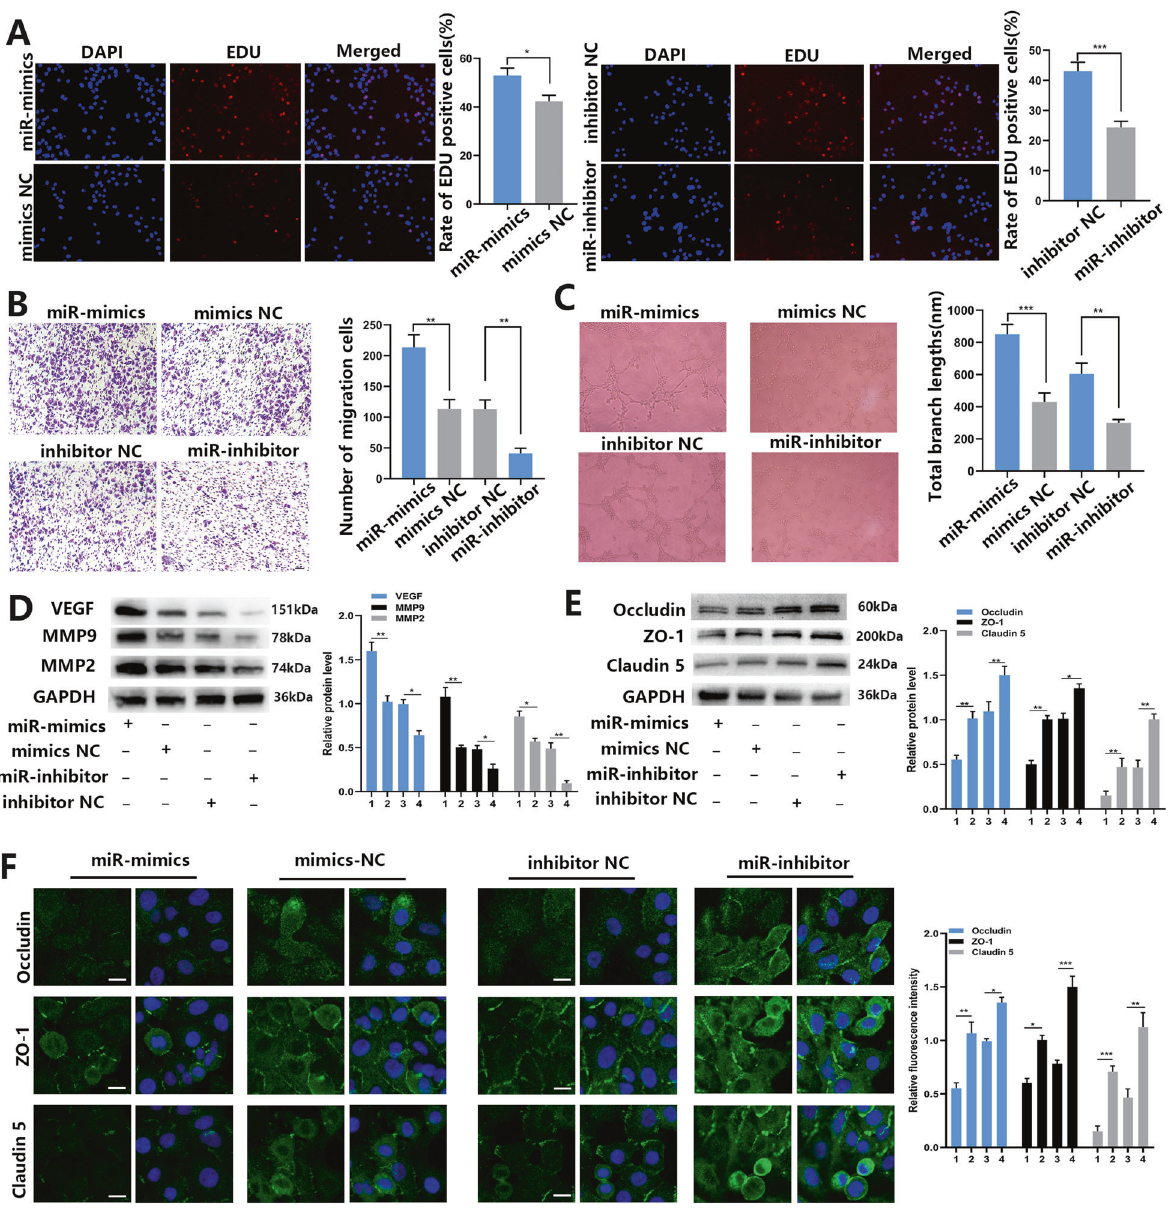
Fig. 3 Restored miR-3157-3p enhances HUVEC proliferation, migration, tube formation, angiogenesis and permeability. A Proliferation of HUVECs transfected with Lv-miR-3157-3p or Lv-miR-3157-3p-inhibitor detected using EdU assay (×400); B migration of HUVEC transfected with Lv-miR-3157-3p or Lv-miR-3157-3p-inhibitor assessed using transwell assay (×100). C Tube formation of HUVECs transfected with Lv-miR- 3157-3p or Lv-miR-3157-3p-inhibitor (×100). D , E Protein levels of TIMP2, VEGF, MMP2, MMP9,KLF2,ZO-1,Occludin, and Claudin5 of HUVEC transfected with Lv-miR-3157-3p or Lv-miR-3157-3p-inhibitor measured using Western blot analysis; F Immuno fl uorescence staining analysis of ZO-1, occludin, Claudin5 expression in HUVECs ransfected with Lv-miR-3157-3p or Lv-miR-3157-3p-inhibitor. Scale bar, 20 μ m. 1: miR- mimics; 2: mimics NC; 3: inhibitor NC; 4: miR-inhibitor; The data are shown as the mean ± SD (* P < 0.05; ** P < 0.01; *** P < 0.001). angiogenesis and vascular permeability. Related processes include HUVEC proliferation (Fig. 5A), tube formation (Fig. 5B), and migration (Fig. 5C). The expressions of ZO-1, Occludin, and Claudin5 were the proliferation, migration, angiogenesis and increased permeability further studied in the IF experiment (Fig. 5D). To further determine in HUVECs in a manner similar to endogenous miR-3157-3p, and the that miRNAs in exosomes play a role in promoting metastasis, we used PCR to study the expression level of miR-3157-3p in each group (Fig. 6A). In addition, treatment with miR-3692-3p inhibitor and GW4869 (an inhibitor of exosome generation), A549/miR-3157-3p- Exos fail to induces angiogenesis and migration of HUVECs (Fig. 6 B, C). We have con fi rmed in WB and found that in HUVEC cells with high miR-3157-3p expression, TIMP2, KLF2, ZO-1, Occludin, Claudin5 Cell Death and Disease (2021)